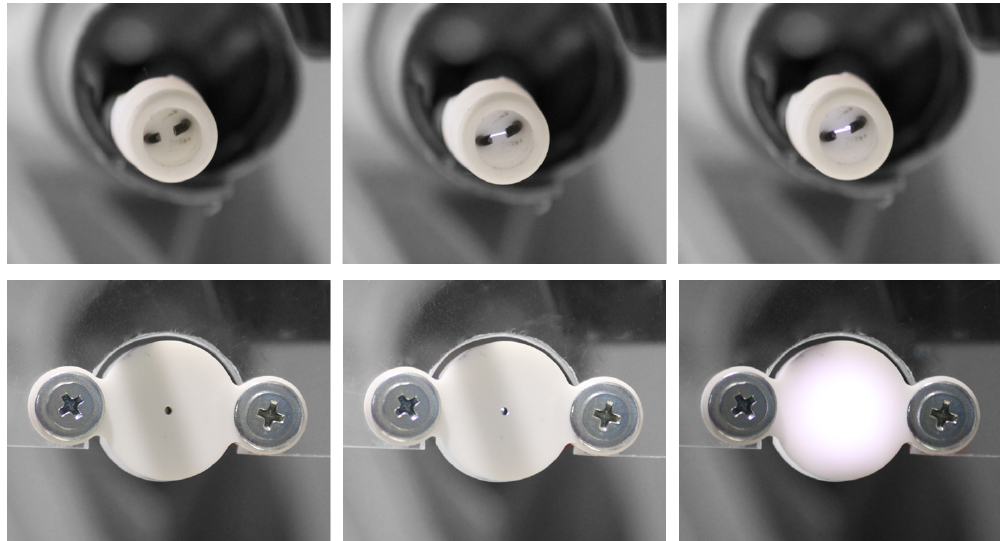
Figure 3. Actuator operating electrical phases. Device bottom part only ( top row ) and whole device ( bottom row ).